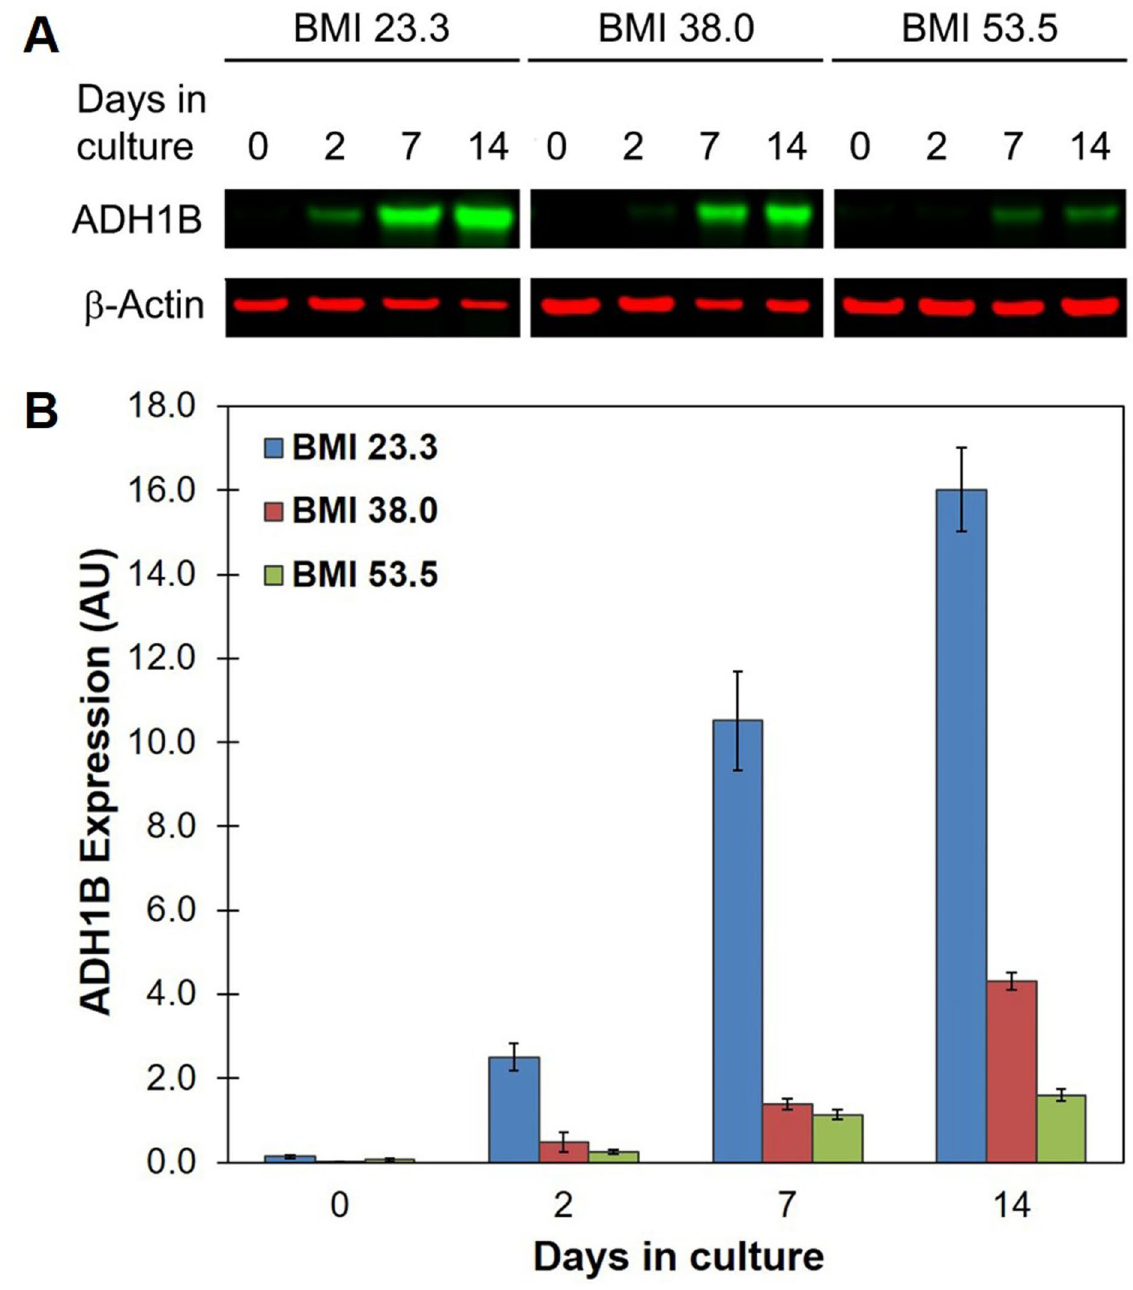
Figure 4. ADH1B protein expression decreased with increasing BMI. ( A ) Representative composite immunoblot image of cell lysates from 3 pre-adipocyte cell lines derived from lean (BMI < 30 kg m −2 ) or obese (BMI ≥ 30 kg m −2 ) individuals during adipogenesis. Total protein was isolated at the indicated time points during differentiation, resolved by SDS-PAGE, and immunoblotted with antibodies specific for ADH1B and β-Actin loading control. Representative full-length blot is presented in Supplementary Figure S14. ( B ) Quantitative analysis of ADH1B expression. Western blot analysis was performed at least four times. Fluorescence intensity was quantified and normalized to β-Actin control. Data is presented as the mean ± s.e.m. AU, Arbitrary